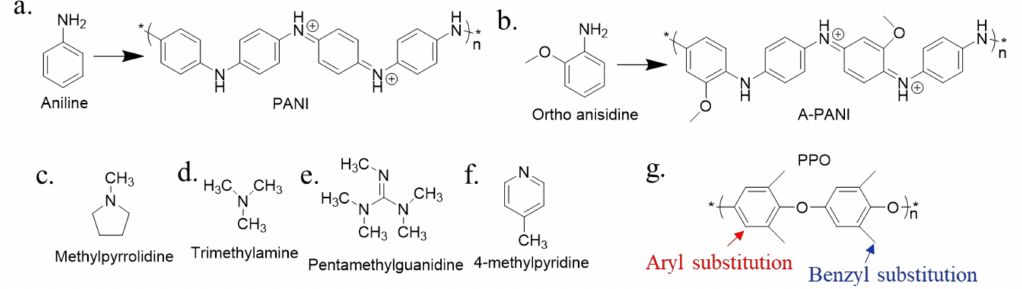
Figure 4. The structure of ( a ) PANI, ( b ) A-PANI, ( c ) Methylpyrrolidine, ( d ) TMA, ( e ) PMG, ( f ) MP, ( g ) PPO